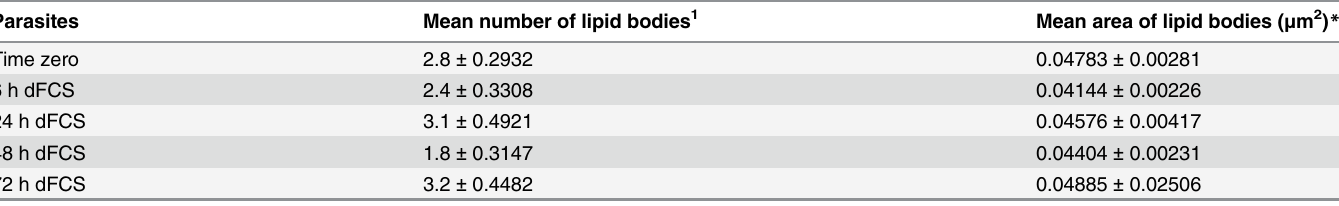
Table 2. Morphometric analysis of the number and the area occupied by lipid bodies in the cytoplasm of epimastigotes cultivated in LIT medium supplemented with 10%